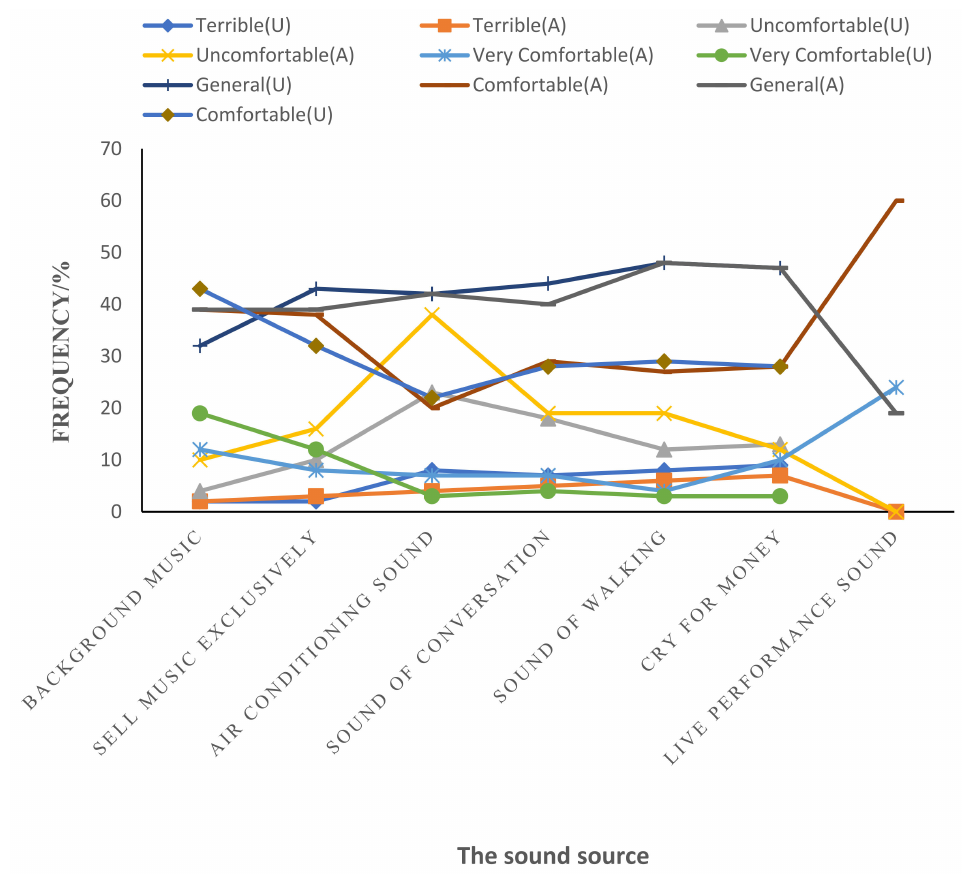
Figure 10. Sound source evaluation analysis diagram of shopping malls (A is above-ground shopping mall; U is for underground